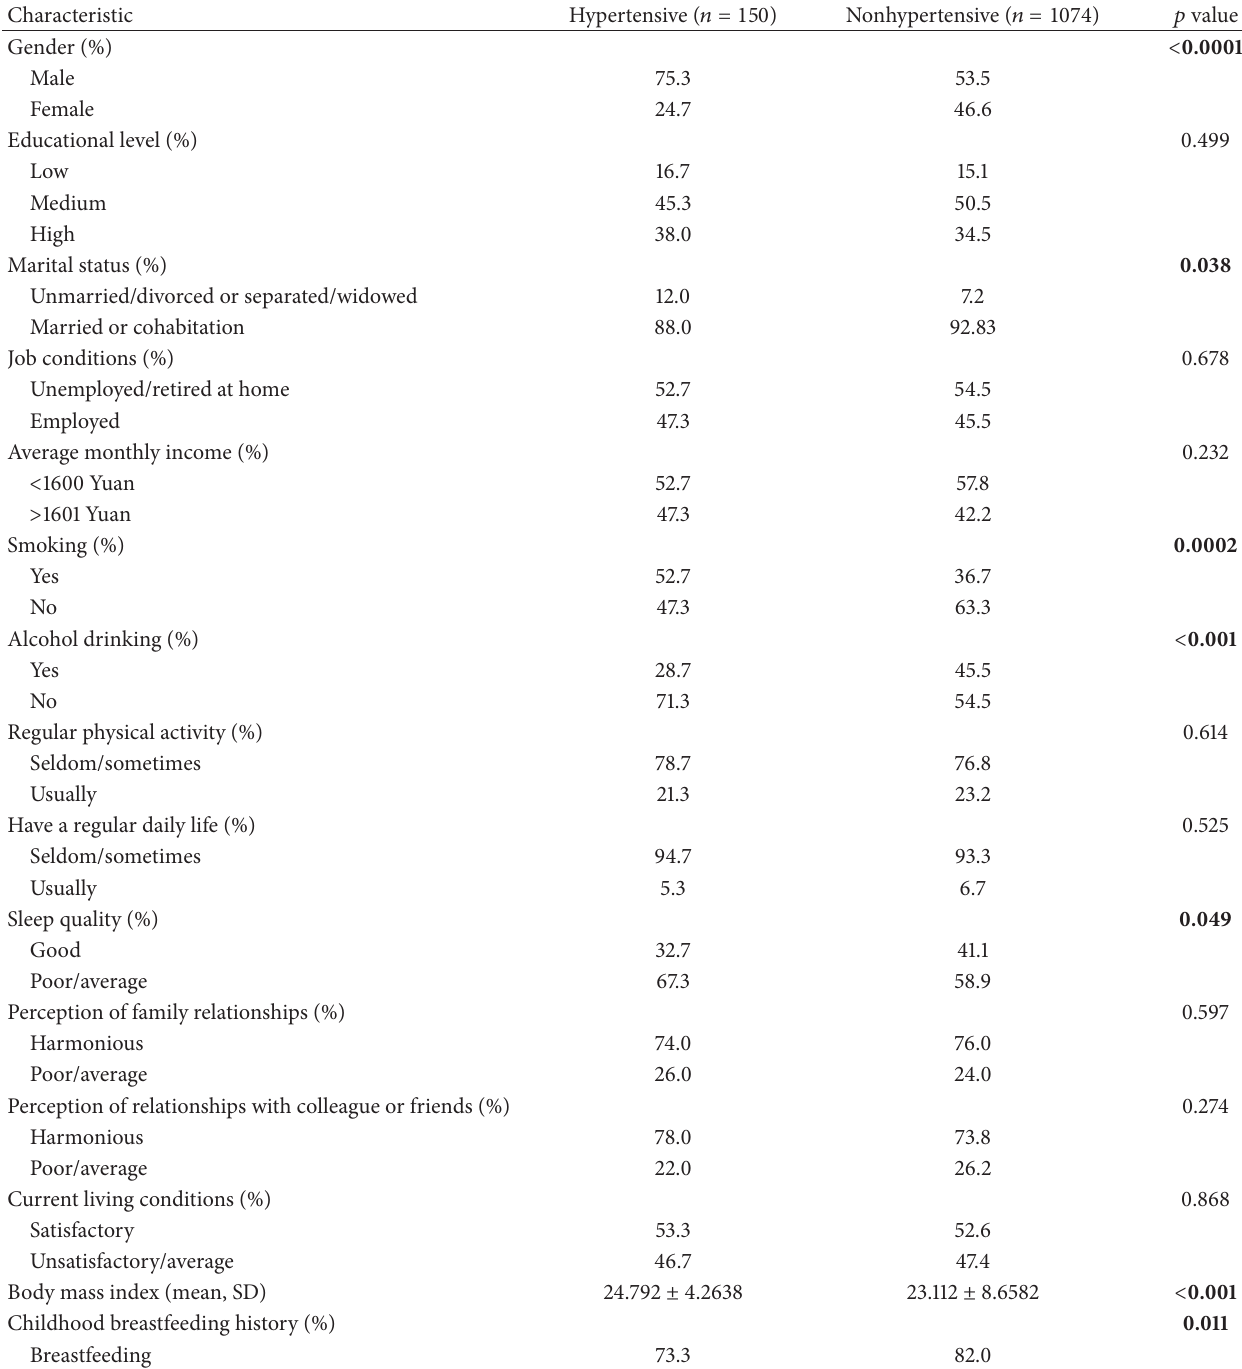
Table 1: Characteristics of participants in Chongqing,